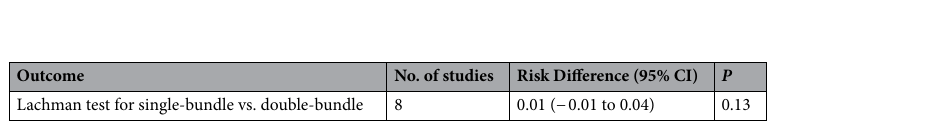
Table 2. Summary of meta-analyses of continuous variables. CI confidence interval, IKDC International Knee Documentation Committee Knee Form.